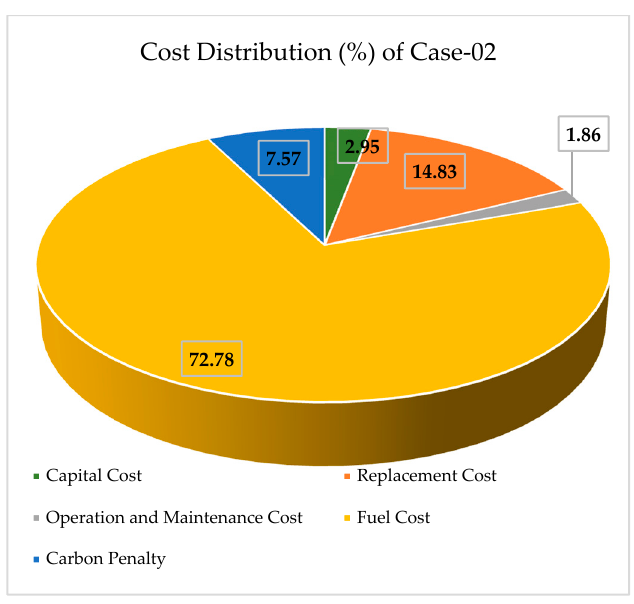
Figure 8. Cost Distribution (Case-2).